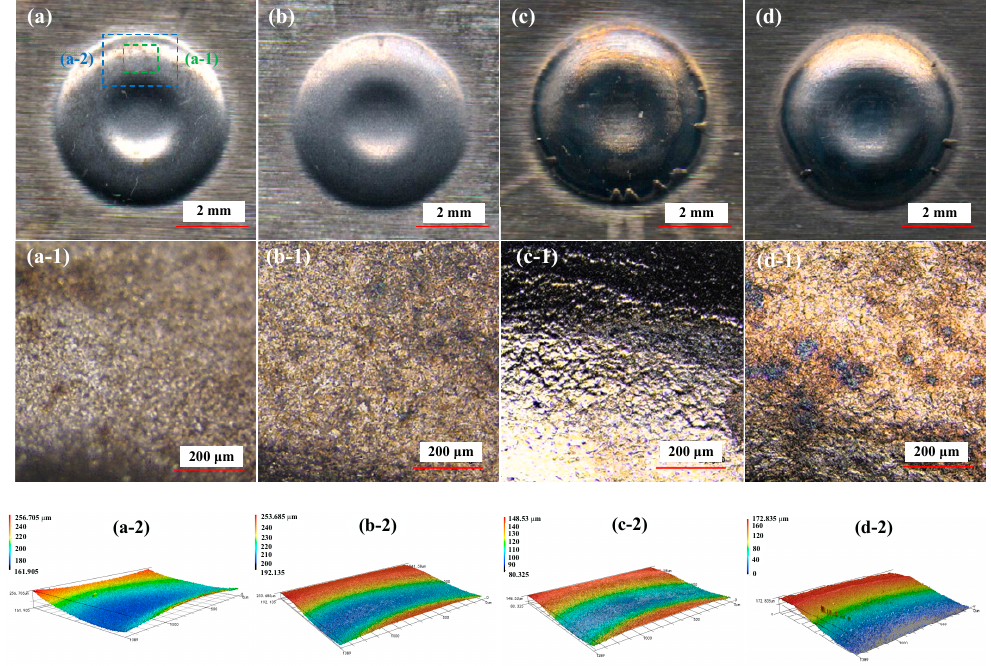
Figure 5. Surface morphology of workpiece at different concentration of NaCl electrolyte: ( a ) 40 A/cm 2 , 50 g/L; ( b ) 40 A/cm 2 ,100 g/L; ( c ) 40 A/cm 2 , 150 g/L; ( d ) 40 A/cm 2 , 200 g/L. Micromorphology of workpiece local surface at different current density in NaCl electrolyte: ( a-1 ) 40 A/cm 2 , 50 g/L; ( b-1 ) 40 A/cm 2 , 100 g/L; ( c-1 ) 40 A/cm 2 , 150 g/L; ( d-1 ) 40 A/cm 2 , 200 g/L. 3D profile of workpiece local surface at different current density in NaCl electrolyte: ( a-2 ) 40 A/cm 2 , 50 g/L; ( b-2 ) 40 A/cm 2 , 100 g/L; ( c-2 ) 40 A/cm 2 , 150 g/L; ( d-2 ) 40 A/cm 2 , 200 g/L.